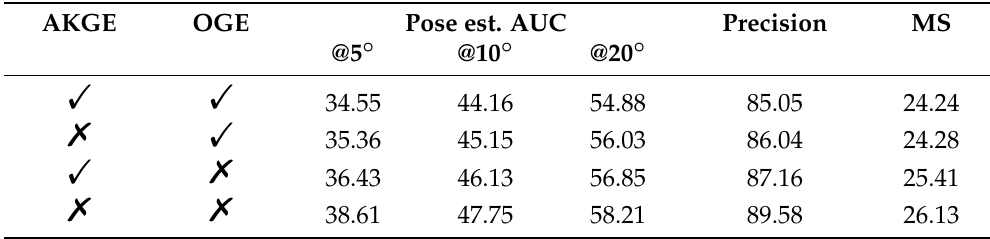
Table 4. Effectiveness of Modules on MegaDepth.